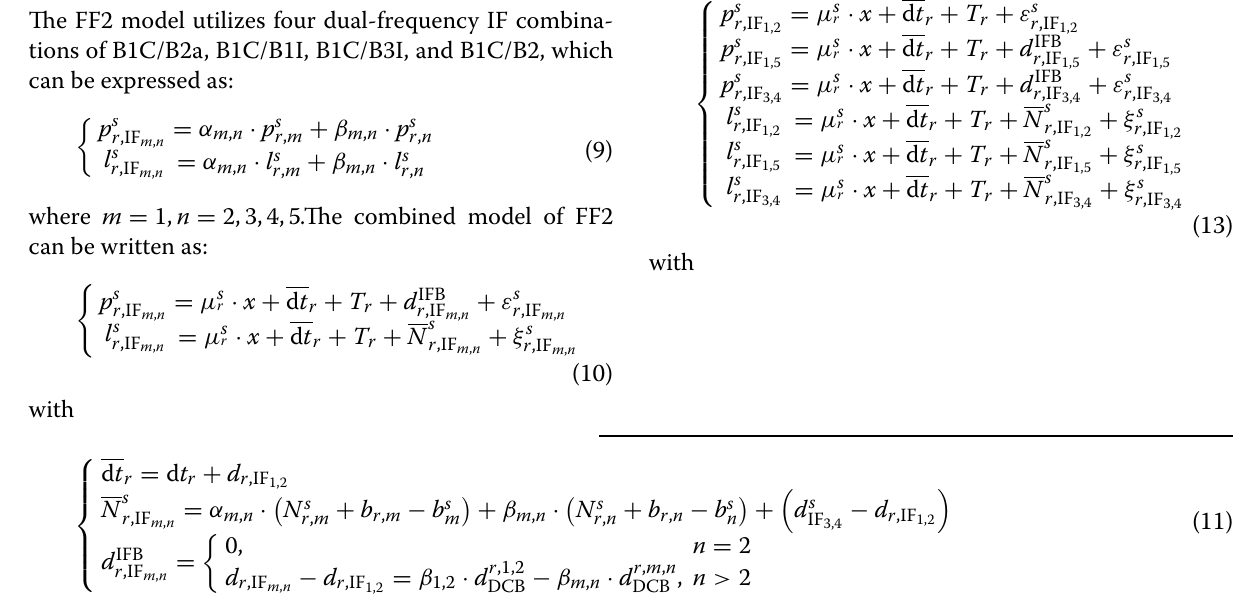
FF2: model with four dual‑frequency IF combined observables